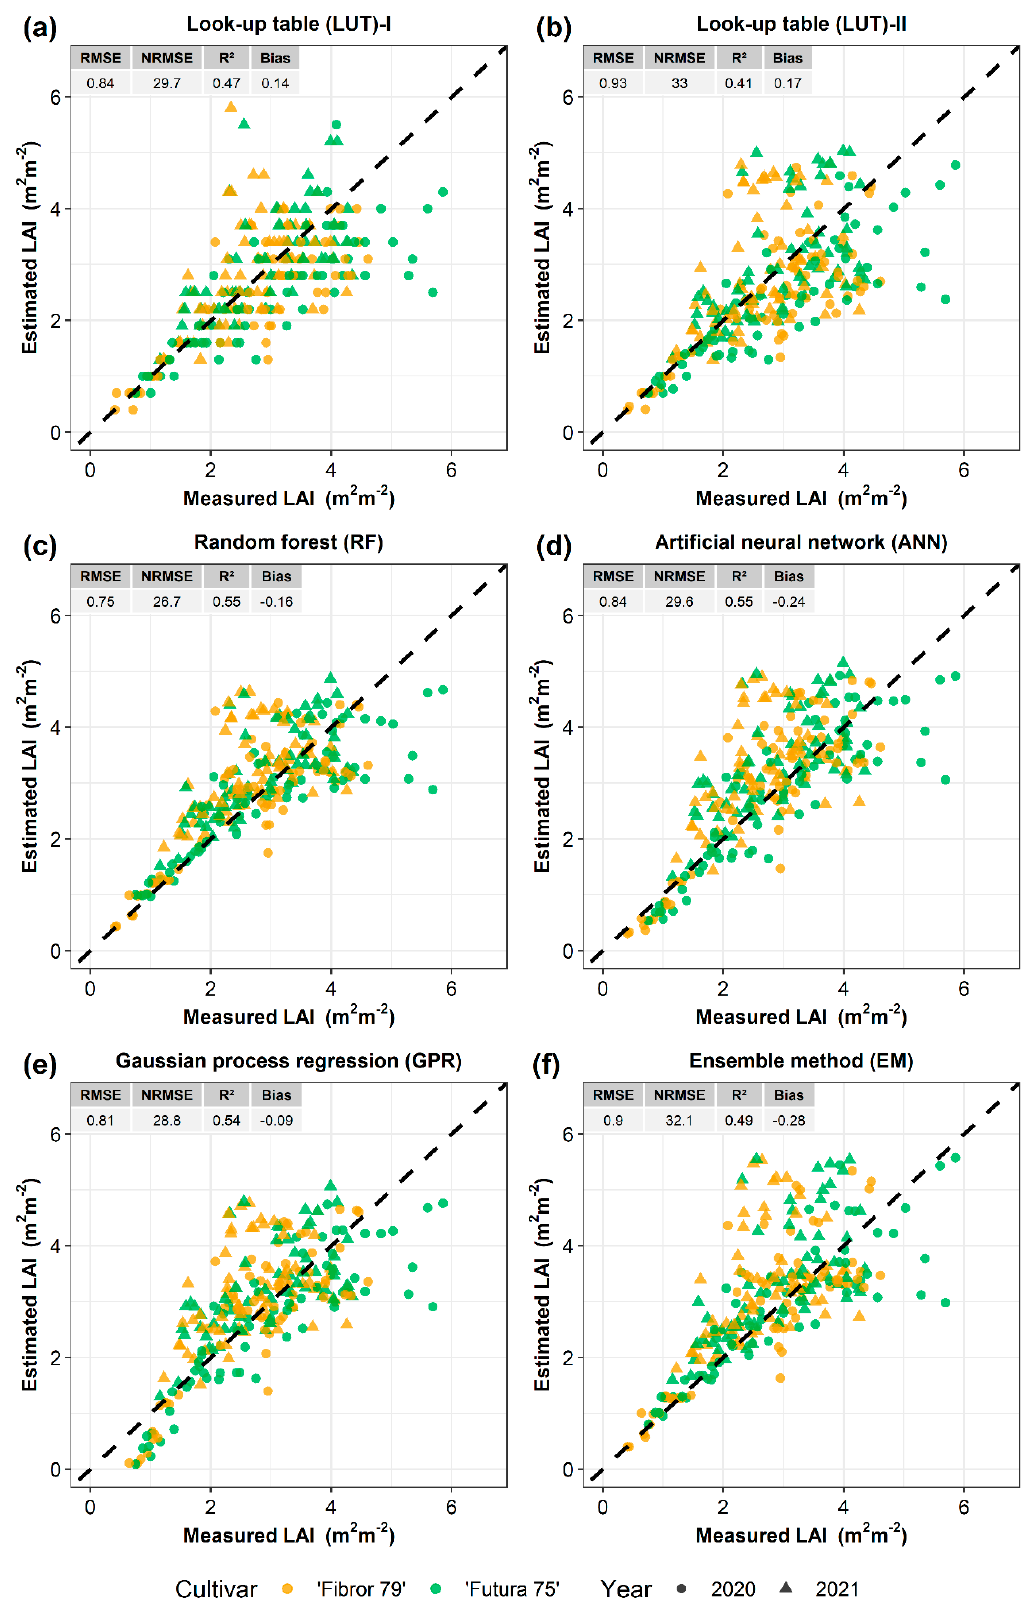
Figure 4. Estimated vs. measured LAI of hemp with different inversion methods: ( a ) LUT-I, ( b ) LUT- II, ( c ) RF, ( d ) ANN, ( e ) GPR, and ( f ) EM.